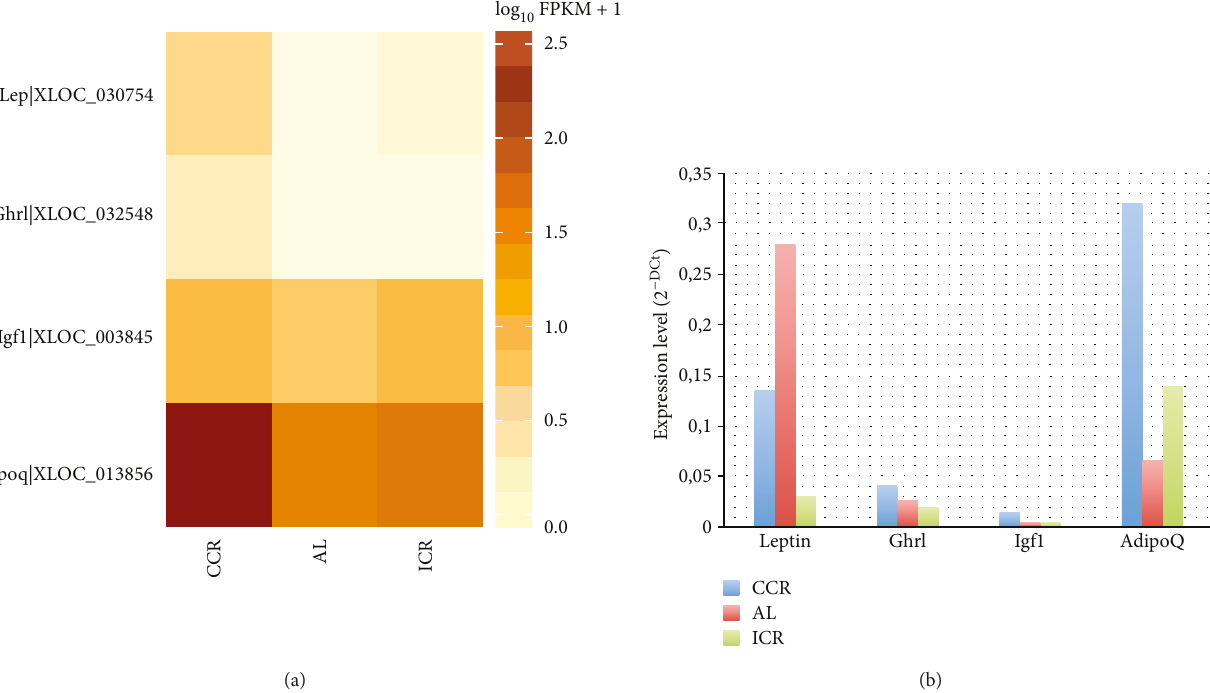
Figure 3: (a) Heat map showing the expression pro fi les of leptin, ghrelin, Igf1, and adiponectin genes in the CCR, AL, and ICR groups revealed by RNA-seq. (b) qPCR validation showing the expression levels of leptin, ghrelin, Igf1, and adiponectin genes in the CCR, AL, and ICR